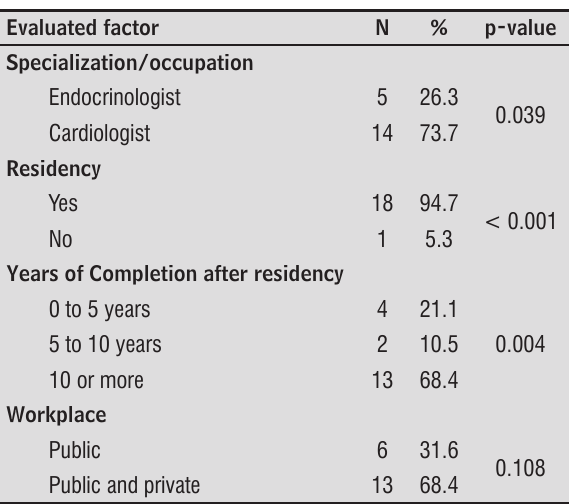
Figure 1 - Flowchart of patients in the study. Table 1 - Characteristics of cardiologists and endocrinolo- gists regarding their age, academic background and workplace